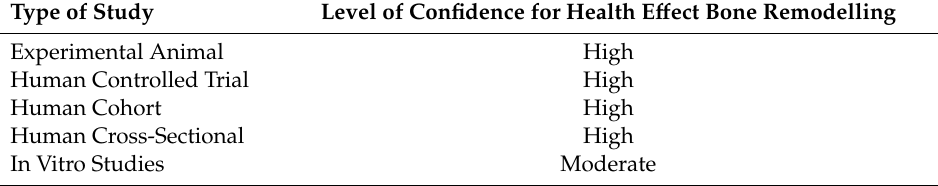
Table A4. Confidence rating for a health e ff ect given strengths and weaknesses of a collection of animal and human